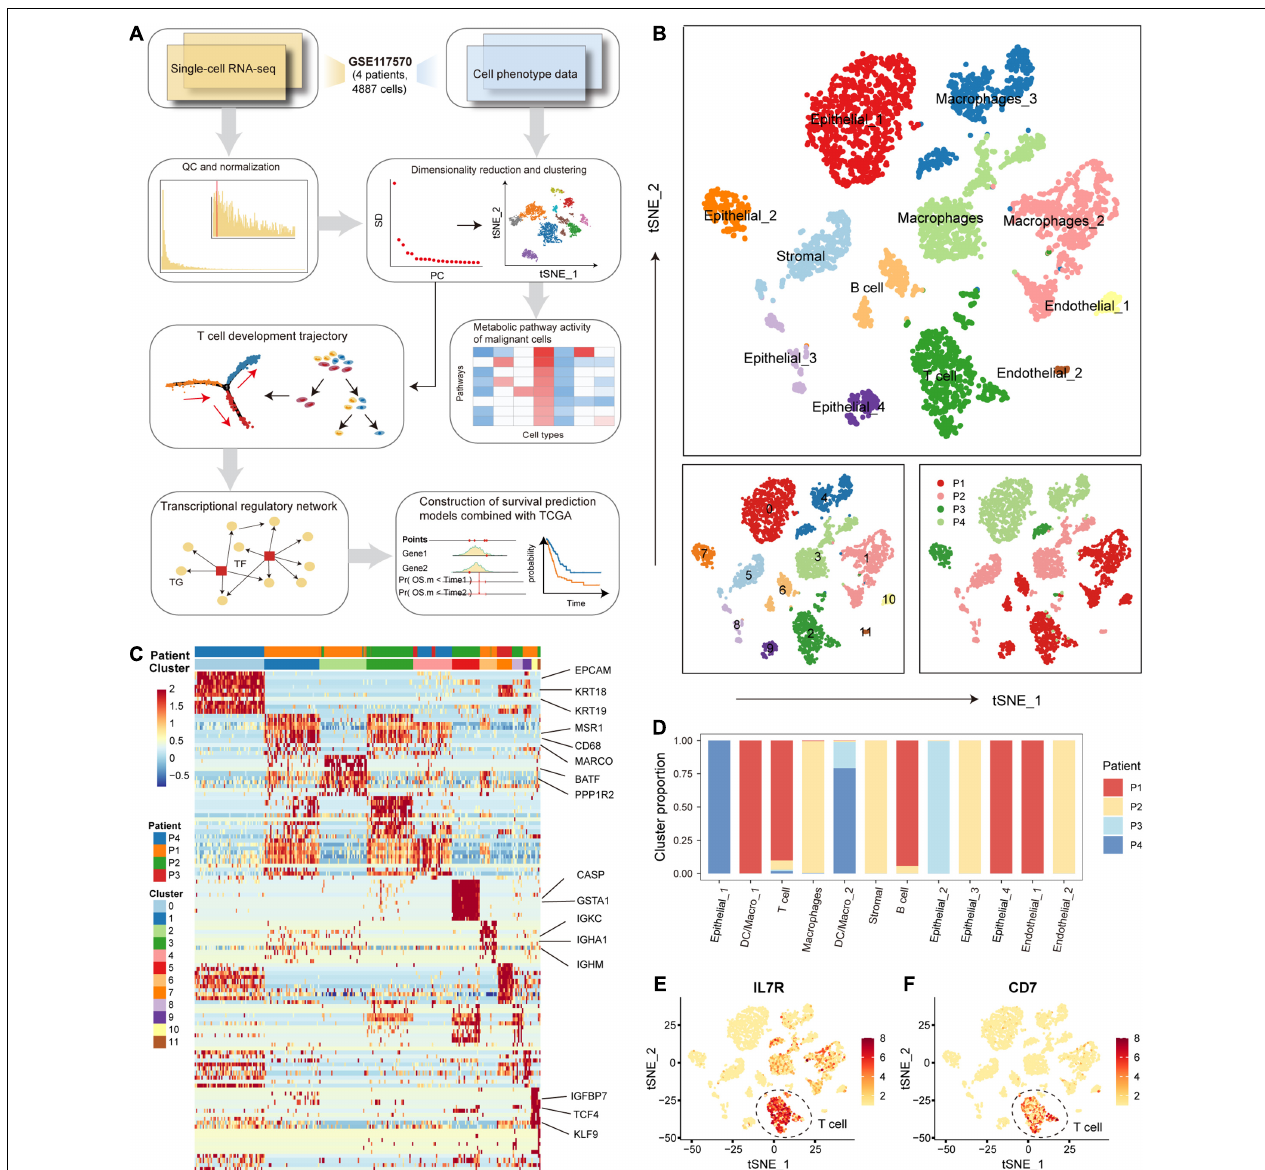
FIGURE 1 | The cellular landscape of non-small cell lung cancer (NSCLC). (A) Workflow diagram representing the pipeline for scRNA-seq data analysis. (B) Tumor cells were clustered by the t-SNE clustering algorithm into 12 clusters with a specific color marker. (C) Heatmap of differentially expressed genes in each cluster. Expression levels of the top 30 genes (rows) that are differentially expressed in each cluster (column). Marker genes in each cluster were annotated. (D) Bar plot of the origin of the cells in each cell type. The horizontal axis is the 12 cell types, and the vertical axis is the proportion of cells. (E) Distribution of IL7 gene expression in all tumor cells. The higher the gene expression, the darker the color. (F) Same as in (E) but for the distribution of gene CD7 .